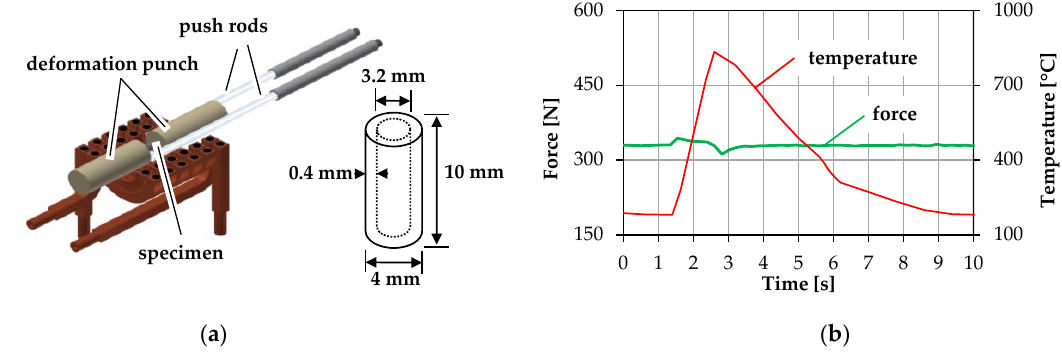
Figure 2. ( a ) Dilatometer DIL805D test apparatus and specimen; ( b ) Testing program to represent one forging cycle.